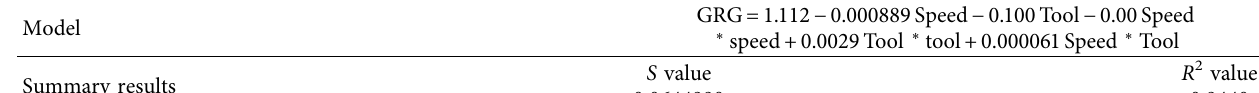
Figure 15: (a) Response surface plot for GRG (cutting speed vs. depth of cut). (b)Contour surface plot for GRG (cutting speed vs. depth of cut). Table 21: Regression model and summary results for GRG.